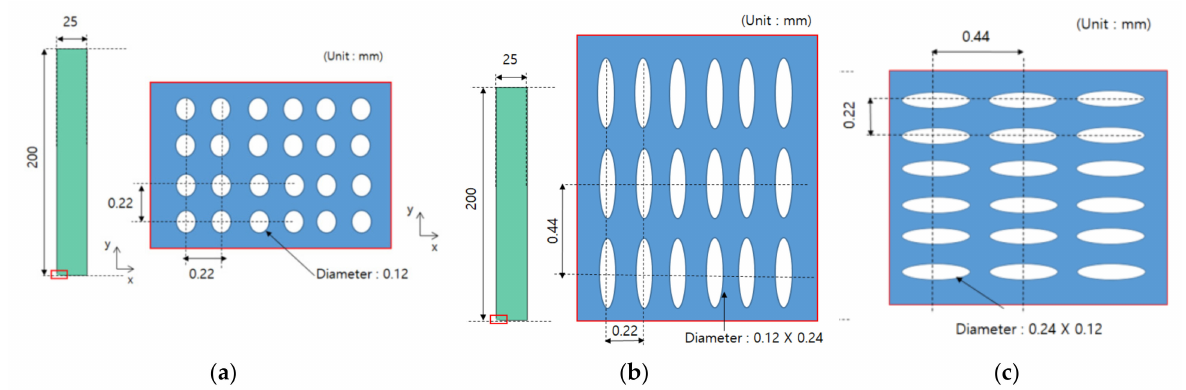
Figure 14. Types of test specimens. ( a ) Specimen with circular pores. ( b ) Specimen with elliptical pores—long axis in the tensile direction. ( c ) Specimen with elliptical pores—short axis in the tensile direction (Reprinted from Ref. [14]).